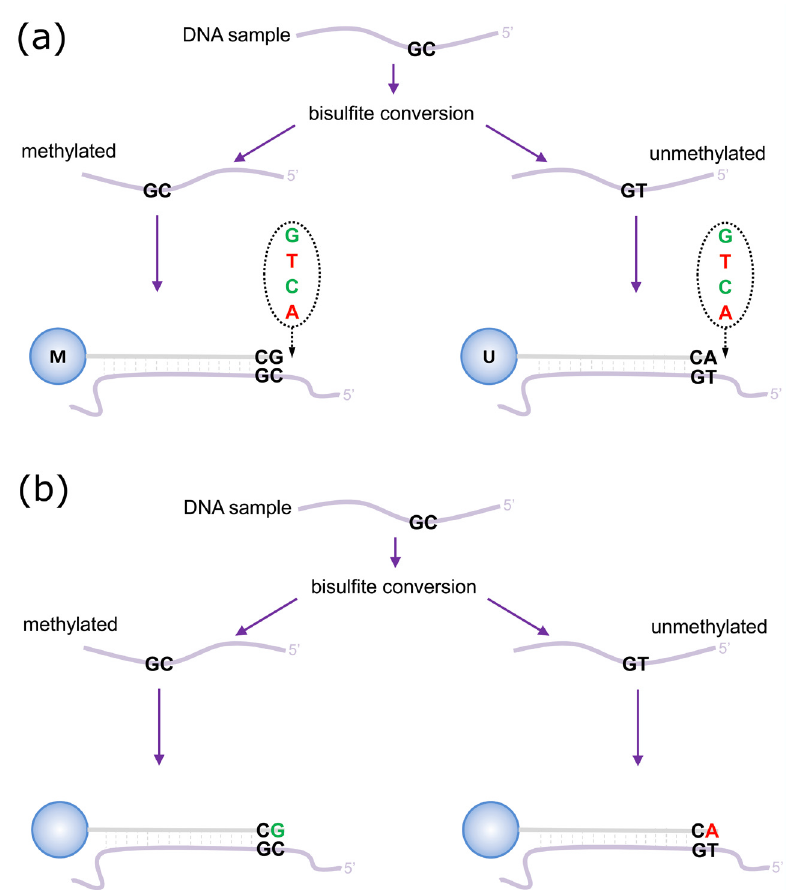
Figure 1. Illumina Infinium HumanMethylation450 assay, reproduced from Maksimovic et al. , 2012. ( a ) Infinium I assay. Each individual CpG is interrogated using two bead types: methylated (M) and unmethylated (U). Both bead types will incorporate the same labeled nucleotide for the same target CpG, thereby producing the same color fluorescence. The nucleotide that is added is determined by the base downstream of the “C” of the target CpG. The proportion of methylation can be calculated by comparing the intensities from the two different probes in the same color. ( b ) Infinium II assay. Each target CpG is interrogated using a single bead type. Methylation state is detected by single base extension at the position of the “C” of the target CpG, which always results in the addition of a labeled “G” or “A” nucleotide, complementary to either the “methylated” C or “unmethylated” T, respectively. Each locus is detected in two colors, and methylation status is determined by comparing the two colors from the one